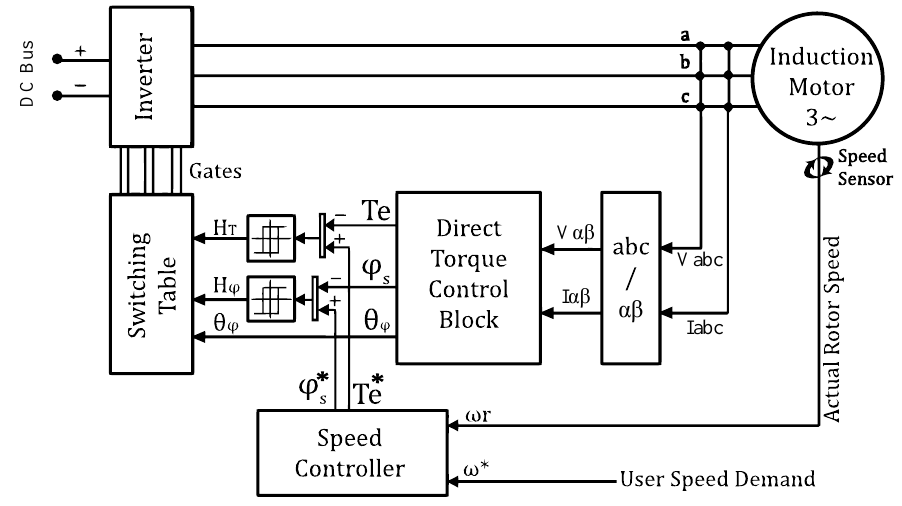
Figure 1. Block diagram of a conventional direct torque control (DTC)